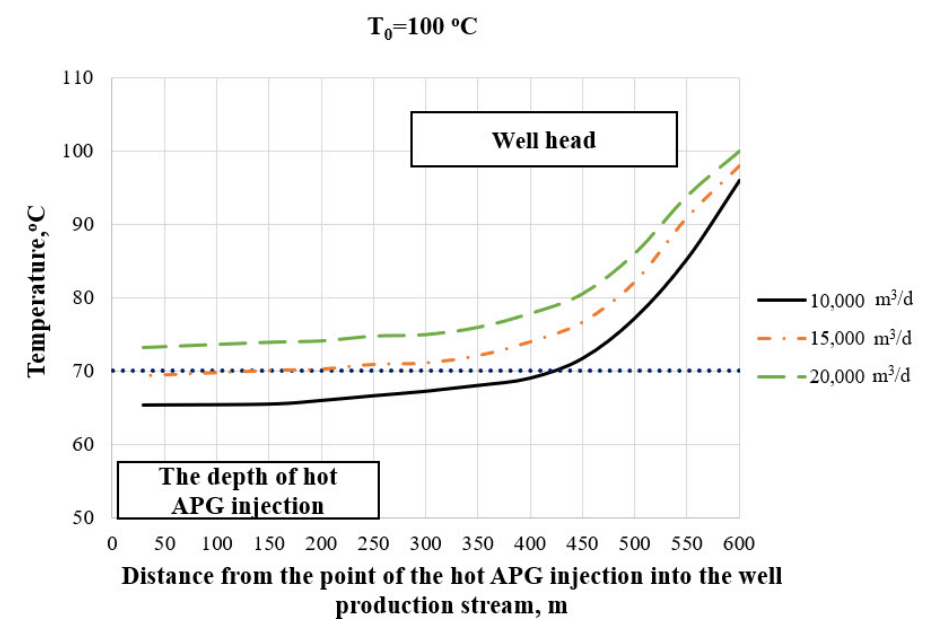
Figure 9. Annulus hot APG temperature profile, inlet T 0 = 100 °C.